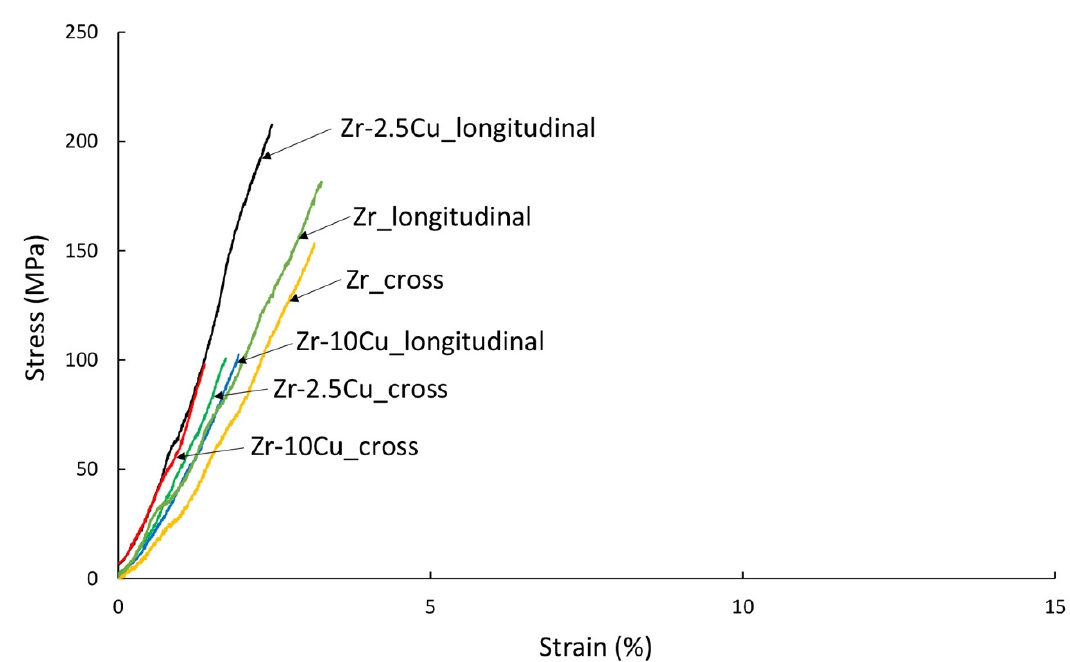
Figure 8. The results of the tensile test of the extruded samples of Zr-2.5Cu and Zr-10Cu at room temperature. Samples were obtained from materials extruded in the direction of the extrusion axis and perpendicular to the extrusion axis.